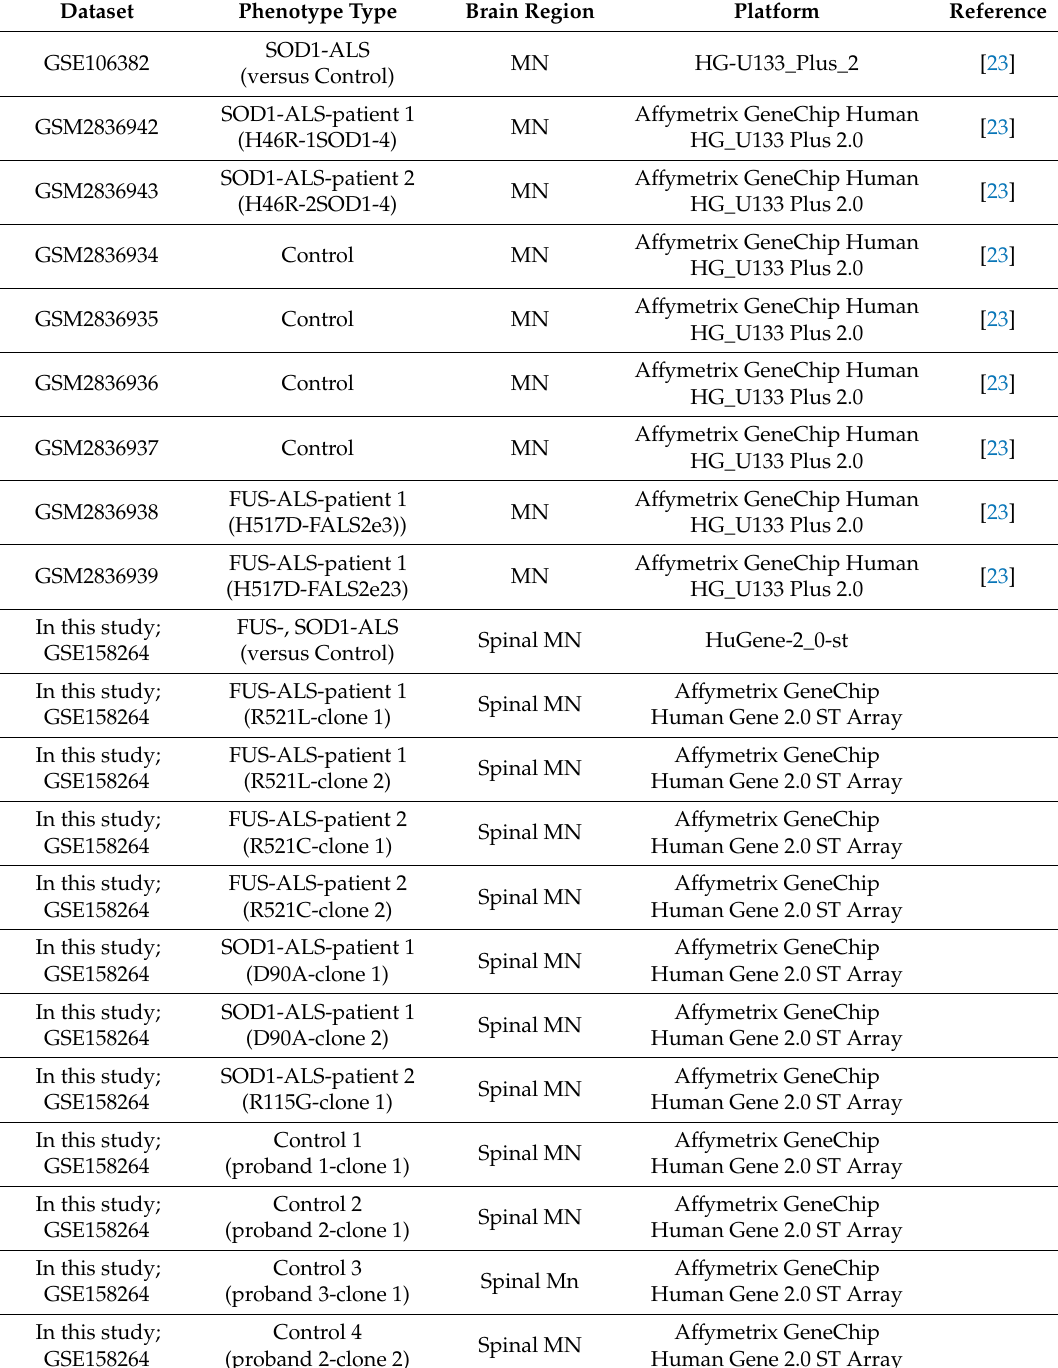
Table 1. Gene expression datasets selected in this